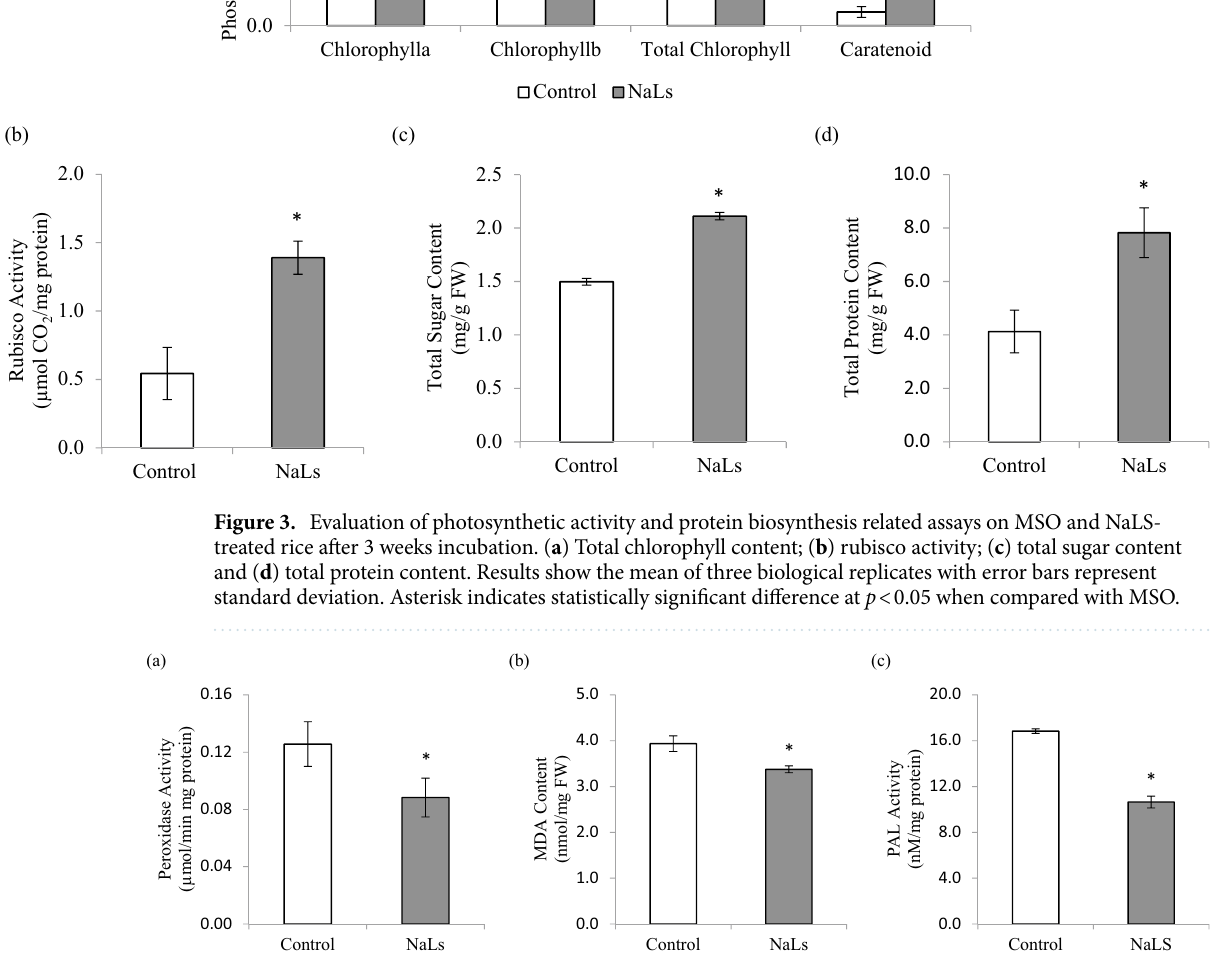
Figure 4. Stress related biochemical assays performed on MSO and NaLS-treated rice after 3 weeks incubation. Selected biochemical assays are ( a ) peroxidase activity; ( b ) malondialdehyde (MDA) content and ( c ) phenylalanine lyase (PAL) activity. Results show the mean of three biological replicates with error bars represent standard deviation. Asterisk indicates statistically significant difference at p < 0.05 when compared with